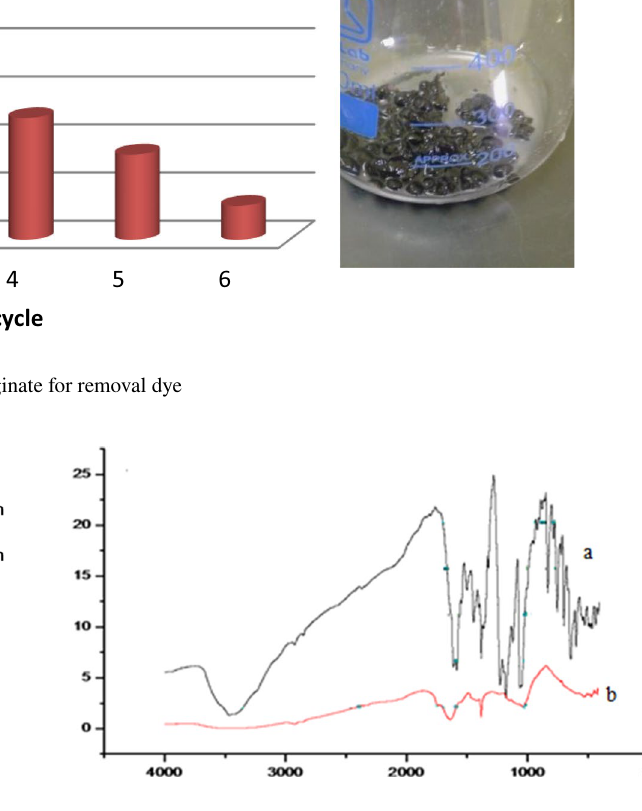
Fig. 7 FTIR spectra of inactive A. niger before ( a ) and after biosorp- tion of CR dye ( b